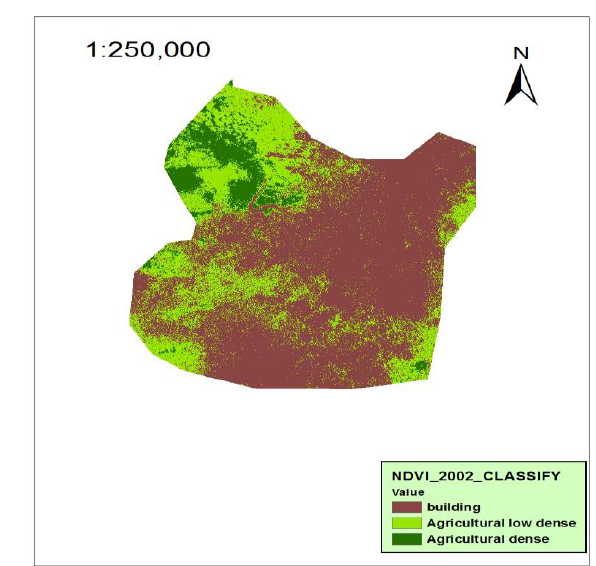
Fig.7: Show NDVI image for study area in date (27/12/2002).